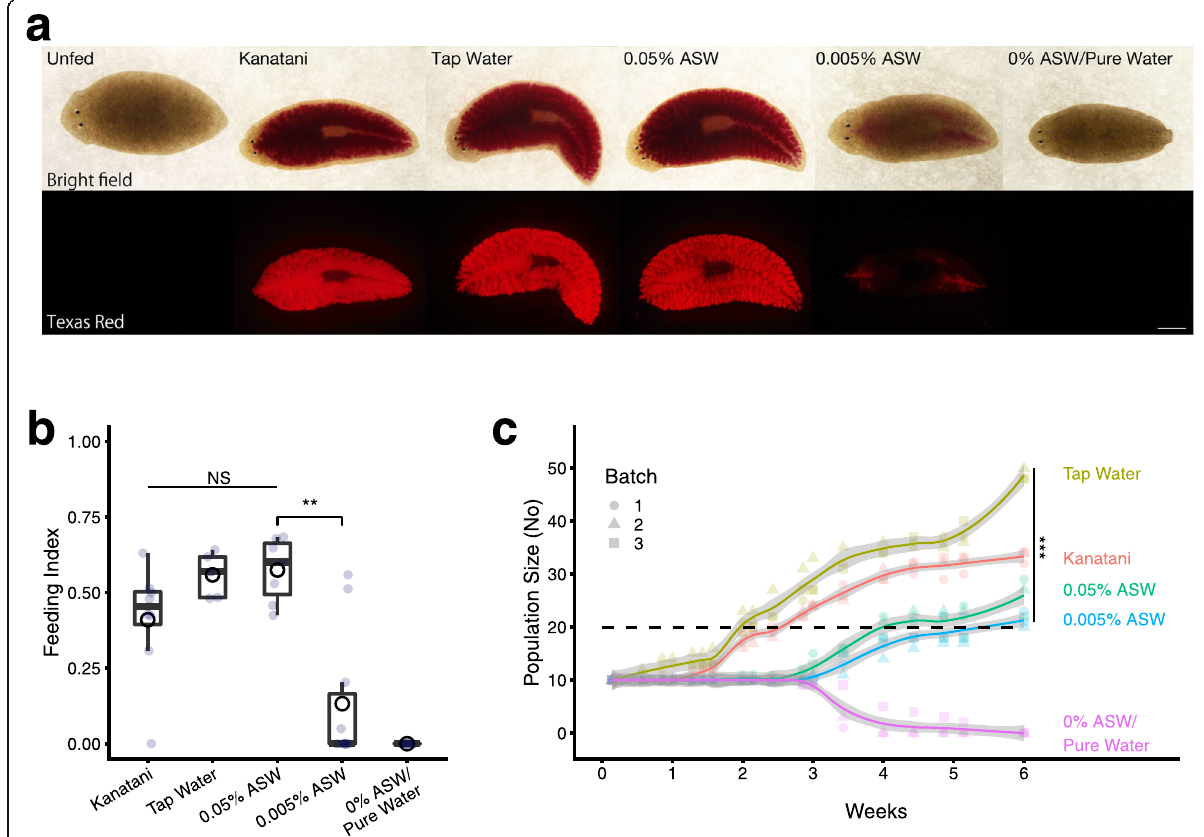
Fig. 1 Breeding water affects food intake and population size. a . Typical living animals that had been cultured in five kinds of breeding water and had then ingested liver homogenate tagged with a pink powder. Ingested food was visualized using a Texas Red fluorescence filter set. No fluorescence signals were detected in the unfed planarians. The strong fluorescence signals were detected in the planarians grown in Kanatani water, tap water, or 0.05% ASW, while weak signals were detected in planarians grown in 0.005% ASW or 0% ASW/pure water. Anterior is to the left. Bar, 1 mm. All animals are shown from the dorsal side. b . The feeding index determined by the ratio between the fluorescence area and the whole body area is shown as a box-and-whisker plot with mean (open circles). The feeding index of planarians grown in Kanatani water, tap water, or 0.05% ASW showed high score and there were no significant differences (NS by Kruskal-Wallis test) among them. By contrast, a low concentration (0.005% ASW) or absence (0% ASW/pure water) of ions in the breeding water reduced the score of the feeding index. **, p < 0.01 (Wilcoxon test). c . Population growth curve of planarians cultured in breeding waters for 6 weeks. The curves are shown as a trend line of three independent batches with 95% confidence interval (gray). The horizontal dashed line indicates the doubling of the number of individuals present at the start point. The number of individuals at 6 weeks was different, depending on the breeding water. ***, p < 0.005